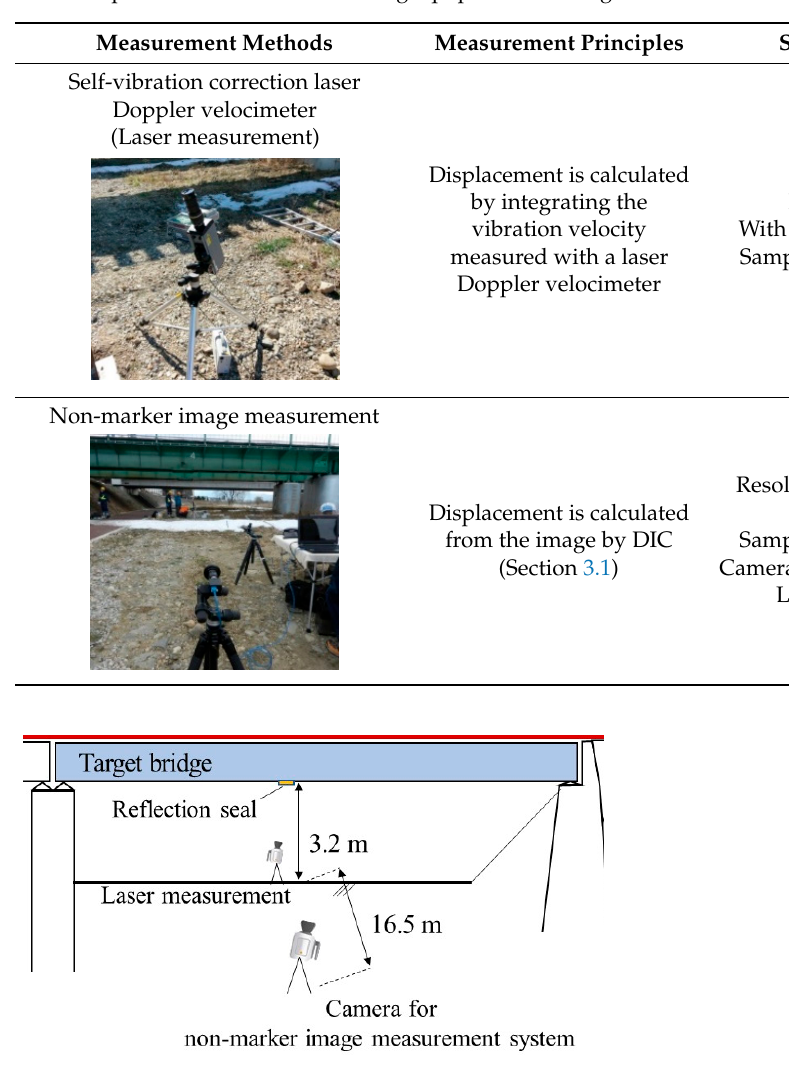
Figure 6. Outline of bridge B: ( a ) bridge span and sketch, ( b ) view of bridge A.